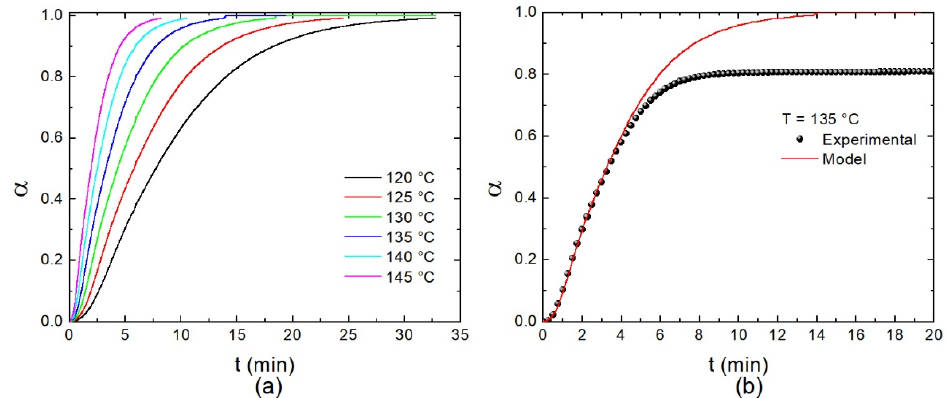
Figure 9. Conversion rate as a function of temperature at different heating rates: ( a ) 4; ( b ) 7; ( c ) 10; and ( d ) 20 °C/min.